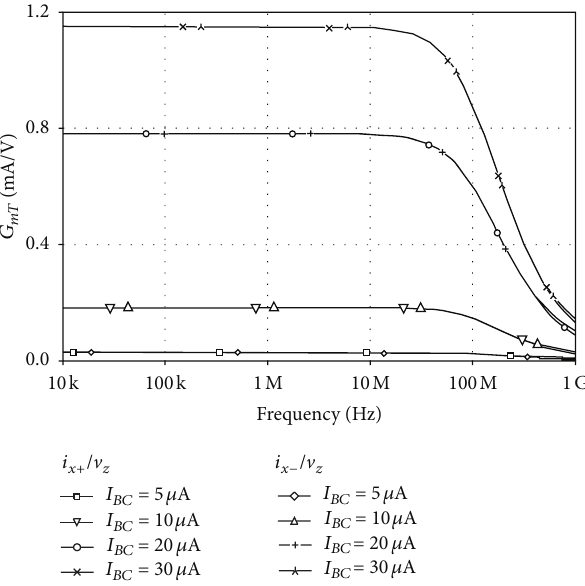
Figure 12: Frequency responses of 𝐺 𝑚𝑇 for different values of 𝐼 𝐵𝐶